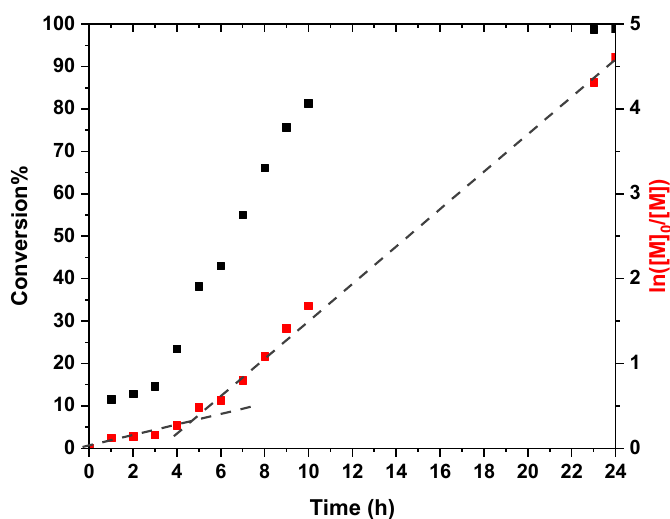
Figure 1. Kinetic data (Conversion %: Black squares, Semi-log: Red squares) obtained for the RAFT dispersion polymerization of HFBMA at 10% w / w solids in ethanol at 70 °C using a PDMA 39 macro-CTA at a macro-CTA/AIBN molar ratio of 5/1. The targeted diblock composition was PDMA 39 –PHFBMA 200 .